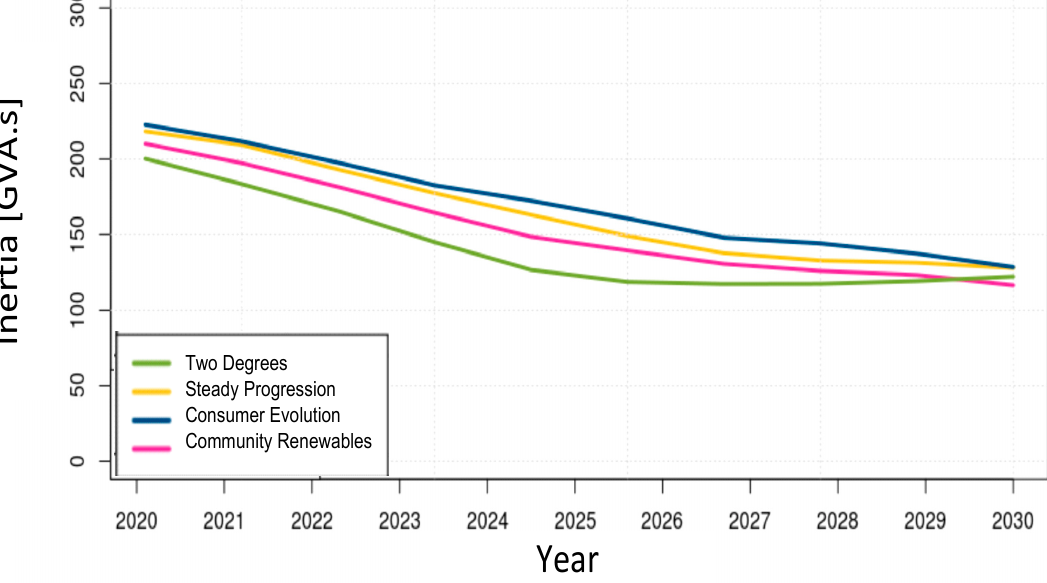
Figure 2. GB inertia trend based on FES 2018 data [1].